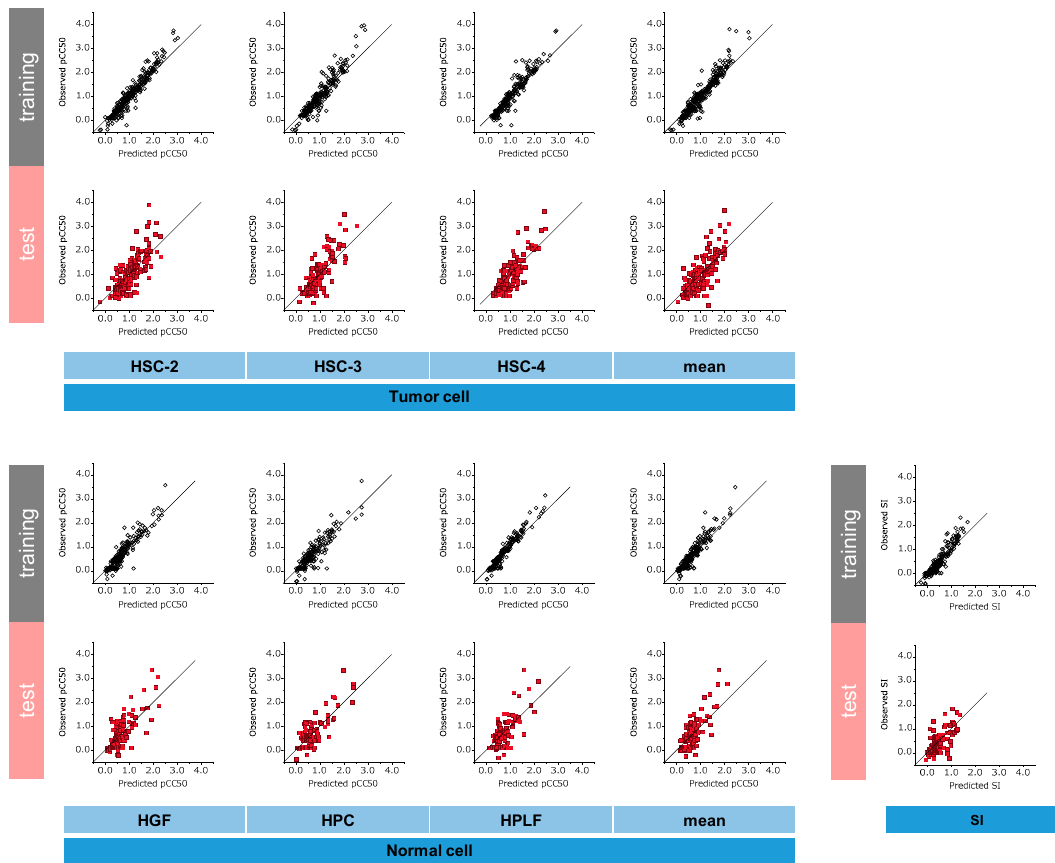
Figure 3. Scatter plot of training set and external validation set. In scatter plots of tumour and normal cell, the horizontal axis is the predicted pCC 50 , and the vertical axis is the observed pCC 50 of tumour and normal cell. In scatter plot of SI, the horizontal axis is the predicted SI, and the vertical axis is the observed SI. Each dot represents a compound; black circle is the training set and red square is the external validation set.